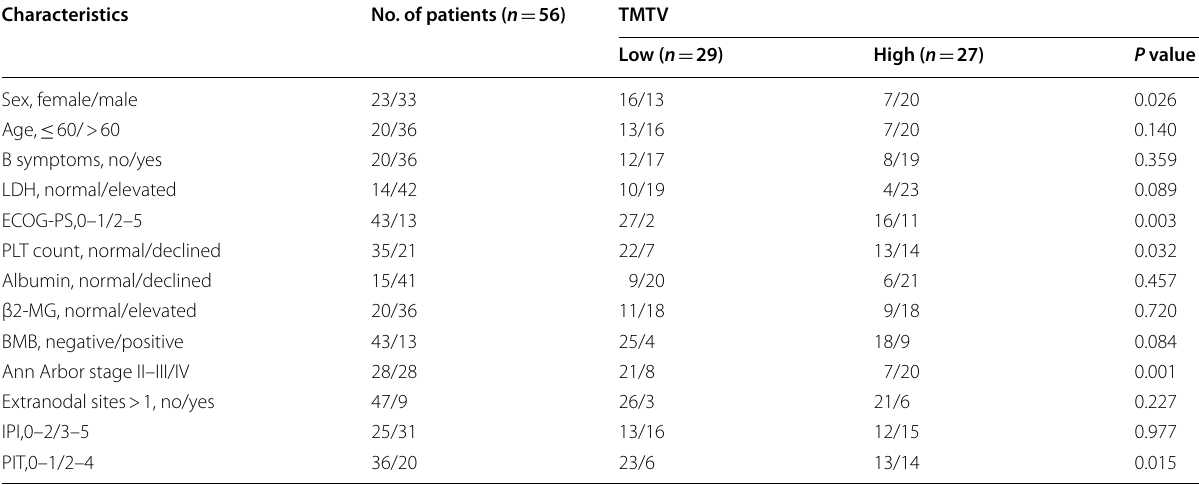
LDH, lactate dehydrogenase; ECOG-PS, Eastern Cooperative Oncology Group Performance Status; PLT, platelet; β2-MG, β2-microglobulin; BMB, bone marrow biopsy; IPI, international prognostic index; PIT, prognostic index for T-cell lymphoma